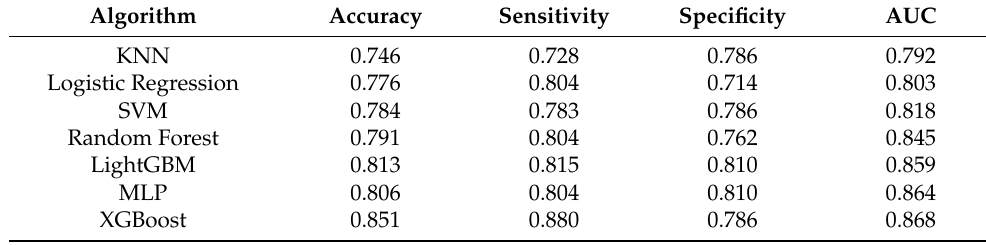
Table 4. Testing results of the predictive models.